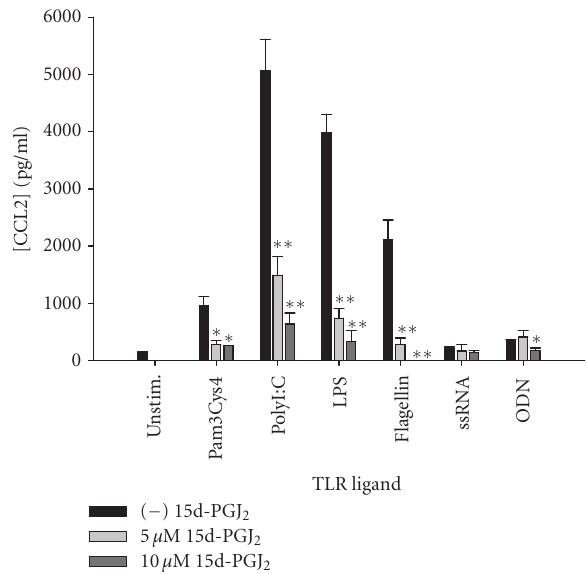
Figure 8: 15d-PGJ 2 is a potent inhibitor of CCL2 release by microglia in response to a wide range of TLR ligands. Primary microglia were plated at 2 × 10 5 cells/well in 96-well plates and incubated overnight. The following day, cells were pretreated for 1 hour with the indicated concentrations of 15d-PGJ 2 prior to the addition of TLR ligands. Cell-conditioned supernatants were collected at 24hours following TLR ligand exposure, whereupon CCL2 levels were determined by ELISA. Significant di ff erences between microglia treated with TLR ligands alone versus TLR ligands + 15d-PGJ 2 are noted with asterisks ( ∗ P < . 05; ∗∗ P < . 001). Results presented are representative of two independent